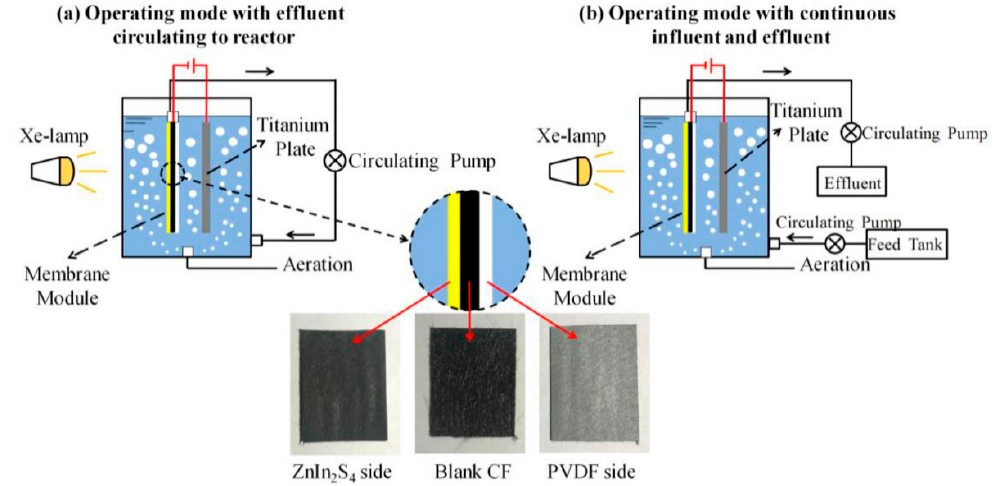
Figure 22. Schematic of the submerged photoanode membrane and separate counter electrode. (Adapted with permission from [94]: Martins, A.S.; Lachgar, A.; Boldrin Zanoni, M.V. Sandwich Nylon/stainless-steel/WO 3 membrane for the photoelectrocatalytic removal of Reactive Red 120 dye applied in a flow reactor. Sep. Purif. Technol . 2020 , 237 , 116338, doi:10.1016/j.seppur.2019.116338. Copyright (2020), Elsevier (Amsterdam, The Netherlands)).